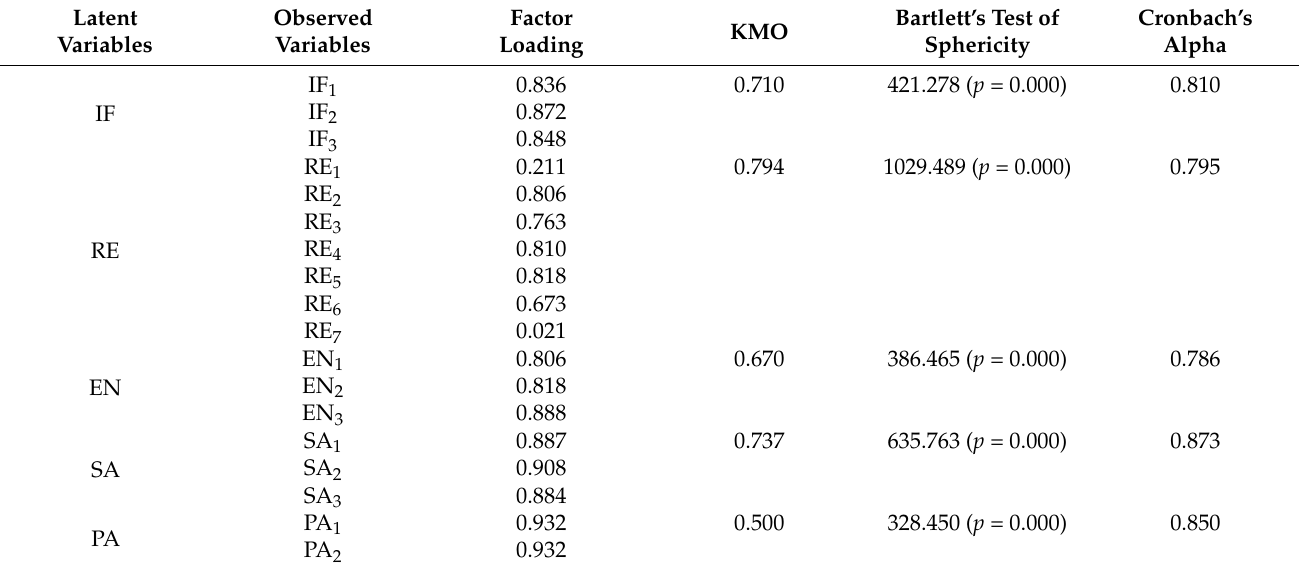
Table 4. Results of exploratory factor analysis and data reliability tests.